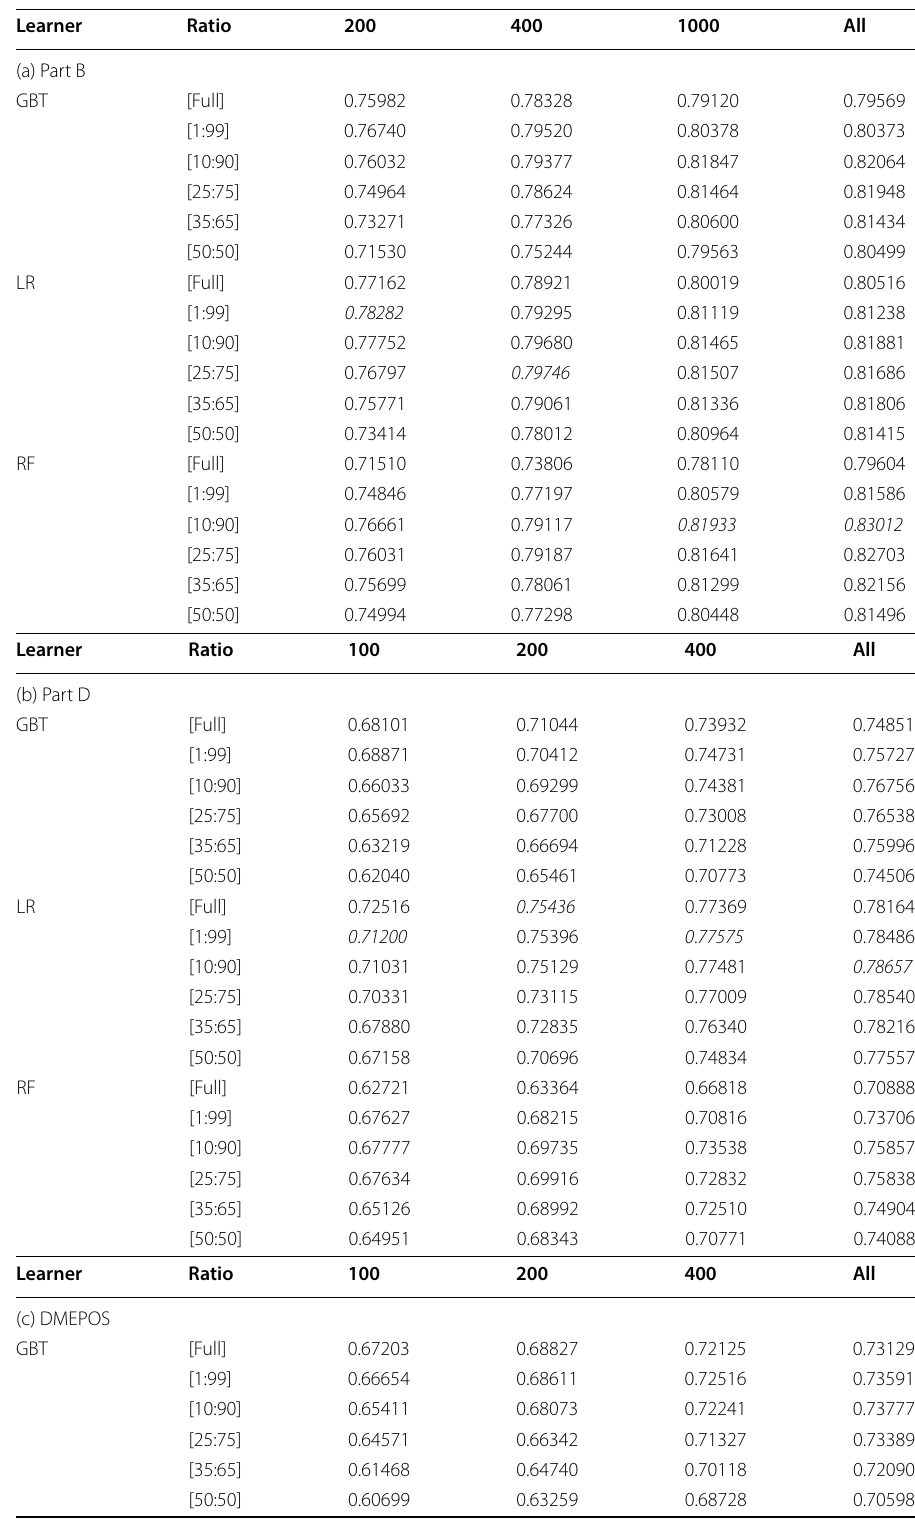
Table 8 AUC Results for